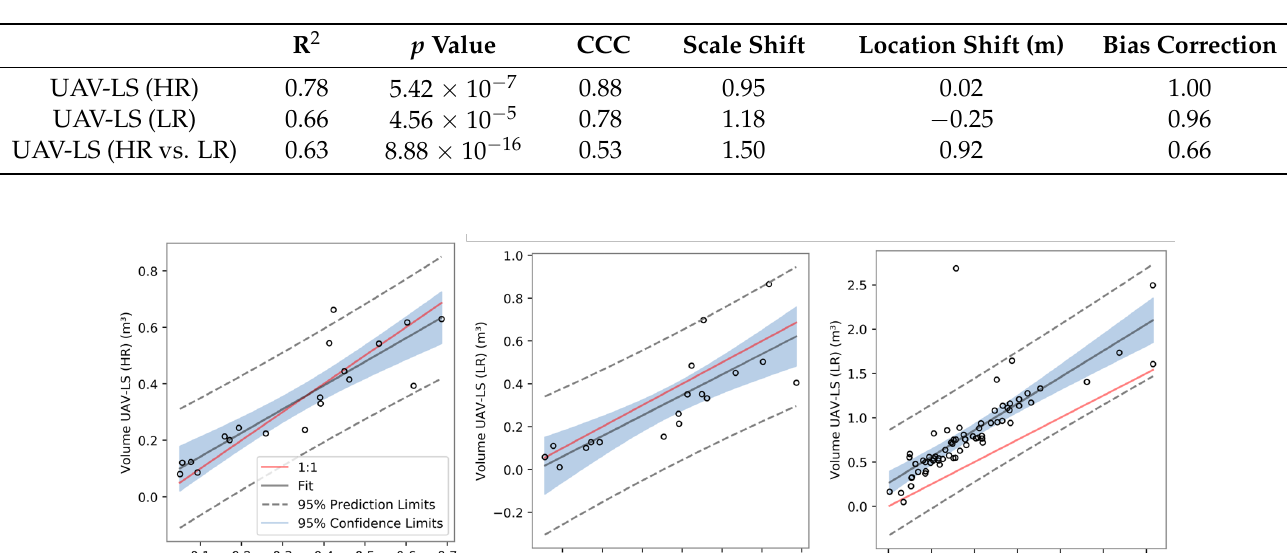
Table 6. Linear regressions and CCC of the volume estimations. For the top 2 rows, the benchmark data set is used as validation.